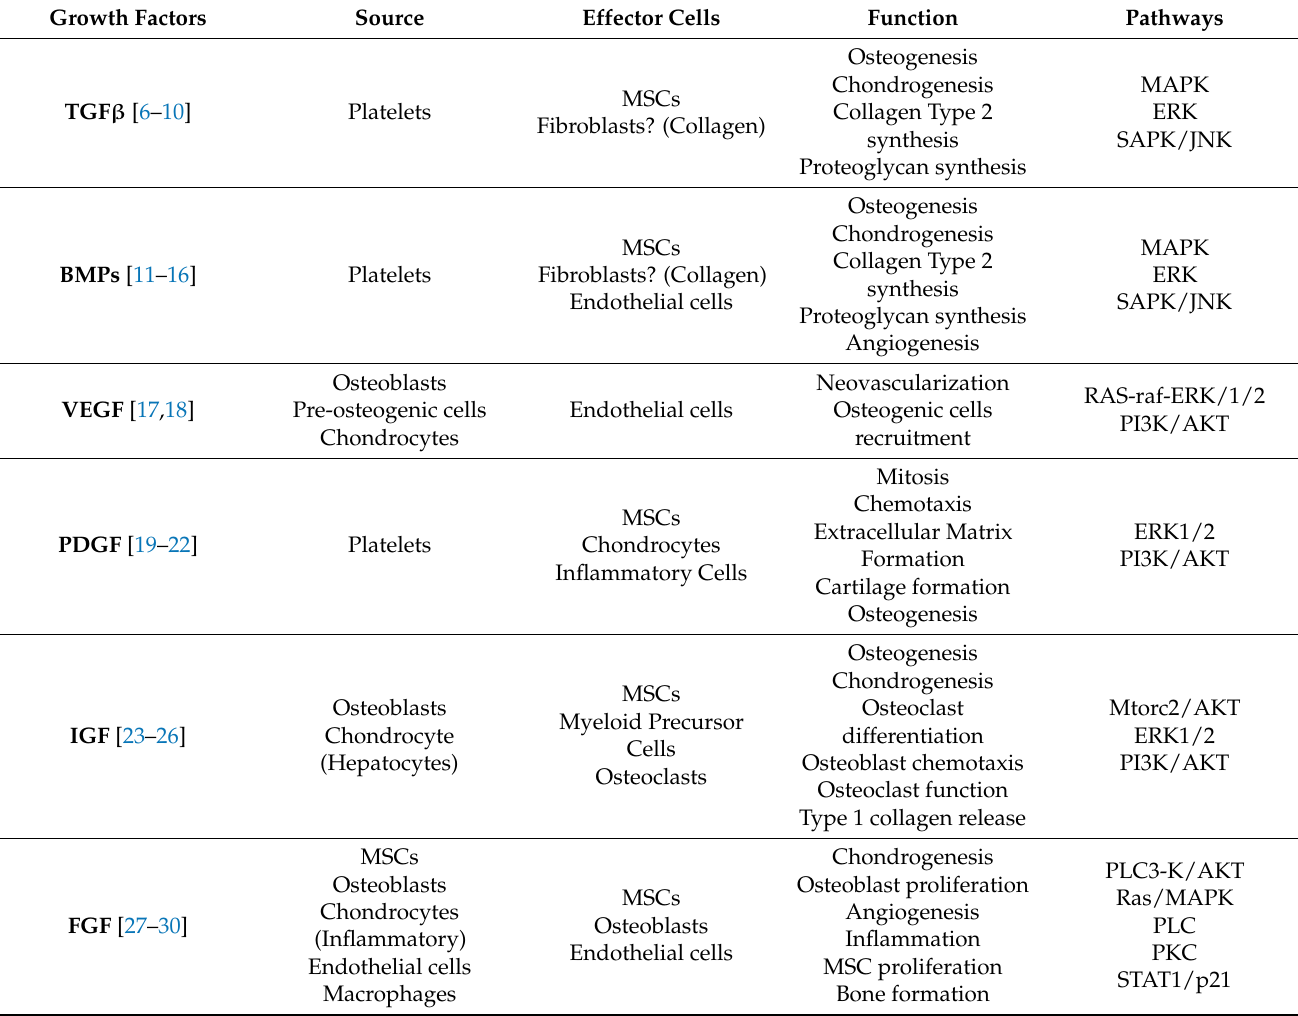
Table 1. Growth factors that enhance bone and cartilage